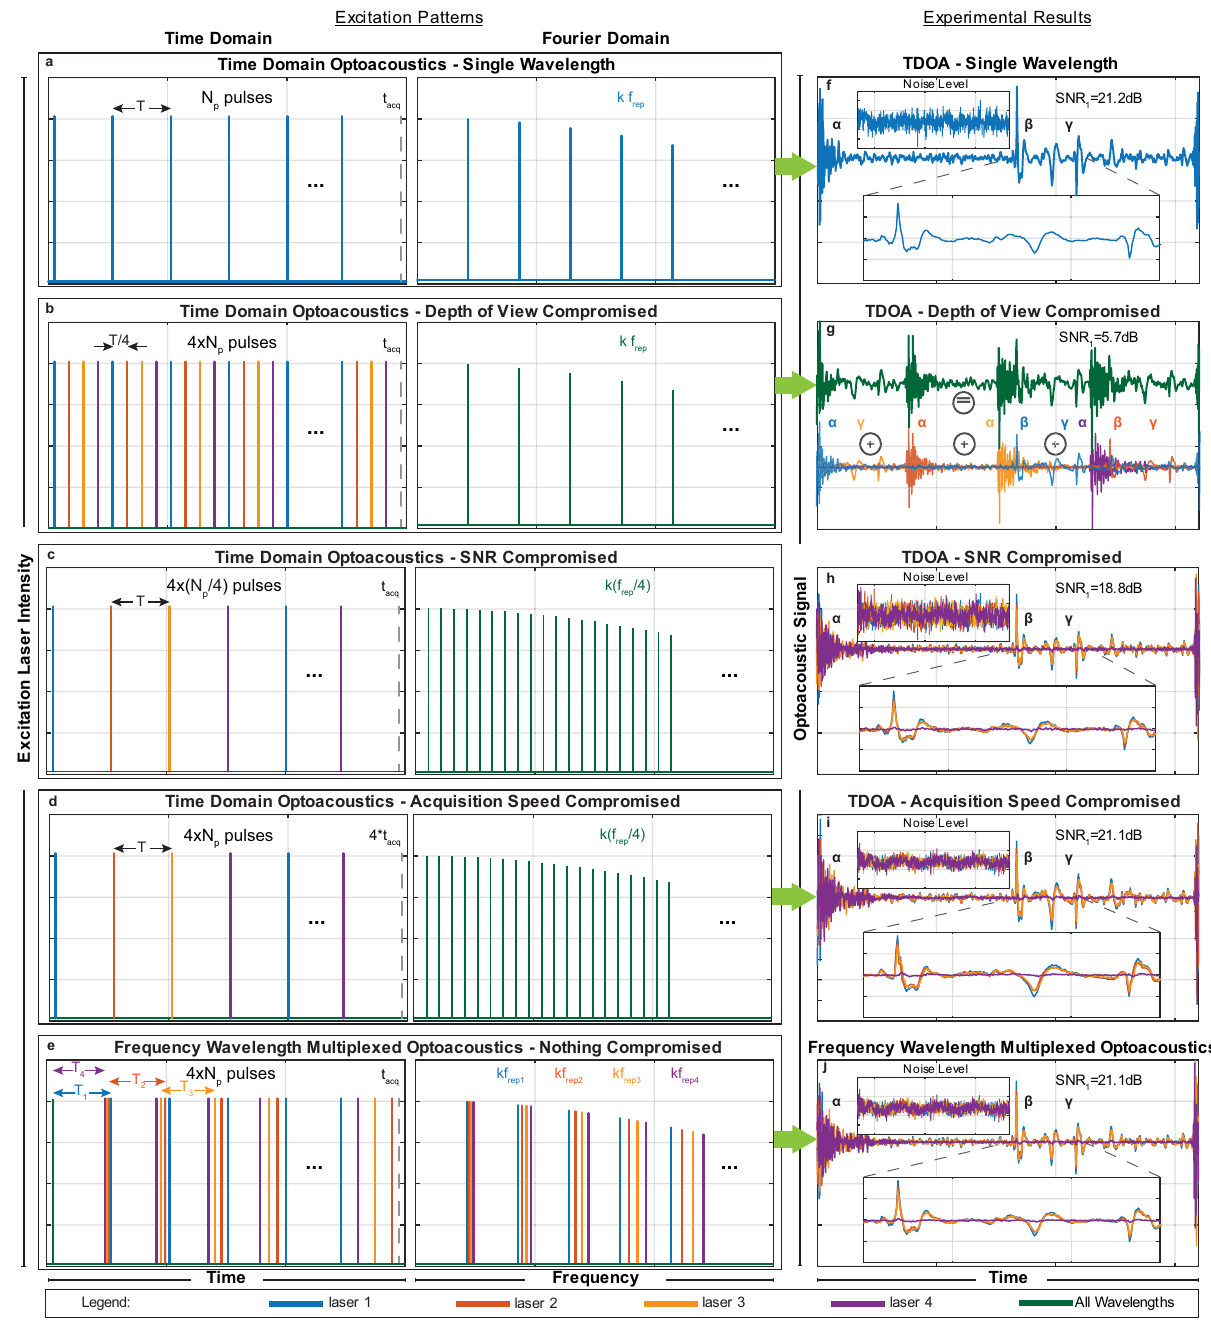
Fig. 2 | Frequency wavelength multiplexed optoacoustic tomography in( a – e ) respectively. The signal-to-noise ratio(SNR)and noiselevelare inset for all (FWMOT)advantagesatmultiplewavelengths.a Apulsetrainofonewavelength cases. f α , the electromagnetic interference from the laser diode circuitry when withperiod T andrepetitionrate f rep =1/ T ,with N p pulsesandacquisitiontime t acq in triggered, β theOAsignalfromtheblackvarnish, γ there fl ectionoftheOAsignalin time domain (TD, left) and Fourier domain (right), with k f rep the harmonics of f rep the petridishorinthe acoustic lens ofthe Ultrasound Transducer. g The OAsignal with k an integer. b – d Multiple wavelength excitation in TD Optoacoustic (OA). from the excitation pattern b for all wavelengths (top line) is the sum of the OA b The excitation pattern of 4 wavelengths emitting at the same repetition rate f rep signalfrom each wavelength (bottom line),with drastically reduced Depth-of-View with a time shift T /4, N p pulses for all wavelengths and t acq acquisition time. c The ( DoV )foreachwavelength.Thelaserinterference,OAsignalanditsre fl ections( α , β , γ ) for each wavelength are indicated. h The OA signal at each wavelength has excitation patternof4 wavelengths with f rep /4repetition rate, N p /4pulses for each wavelength and t acq acquisition time. d The excitation pattern of four wavelengths reducedSNR. i TheOAsignalhasthesameSNRbutwithincreasedacquisitiontime. j Signal from all four wavelengths has been recovered without any cross-talk with f rep /4repetitionrate, N p pulsesperwavelengthbutwith4 t acq acquisitiontime. e FWMOTexcitationwhereallfourwavelengthshavedifferentrepetitionrates f rep,1 , betweenthe lasersand correctlyco-registeredin timewithoutcompromising DoV, f f f N t – j TheOA SNR or acquisition time. Blue, red, orange, purple, and green are used to indicate rep,2 , rep,3 , rep,4 , p pulsesforeachwavelengthand acq acquisitiontime. f signalrecorded byablackvarnishlayeronapetridishfromtheexcitationpatterns laser 1, laser 2, laser 3, and laser 4,